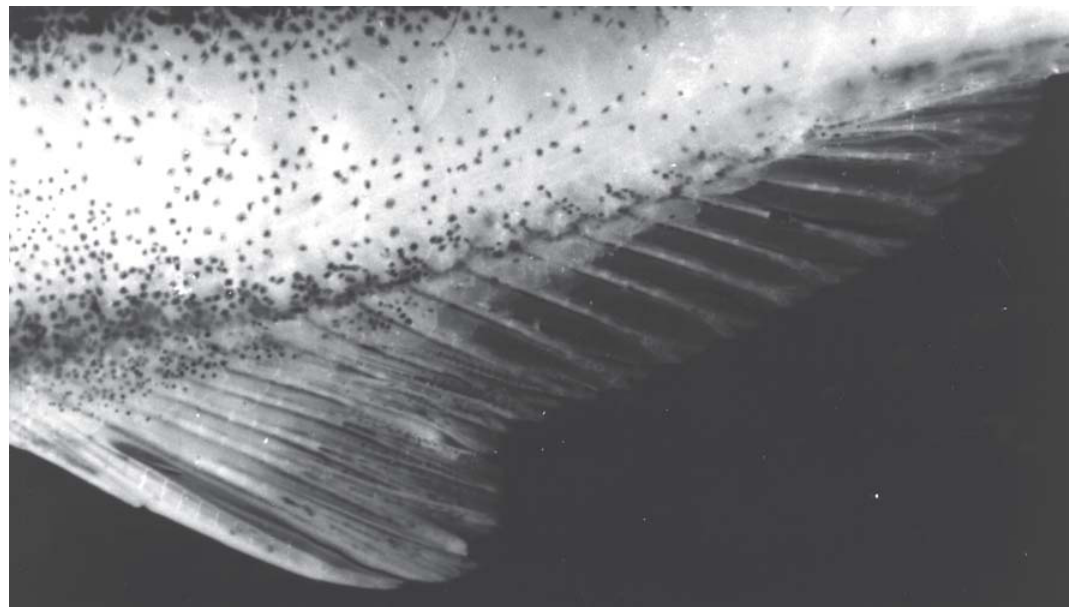
Fig. 8. Bryconadenos tanaothoros , new species, USNM 352061, paratype, SL 34.4 mm, adult female. Lateral view of left side of anterior region of anal fin illustrating absence of glandular organ. Brazil: Mato Grosso: tributary to rio Suiazinho, near Ribeirão